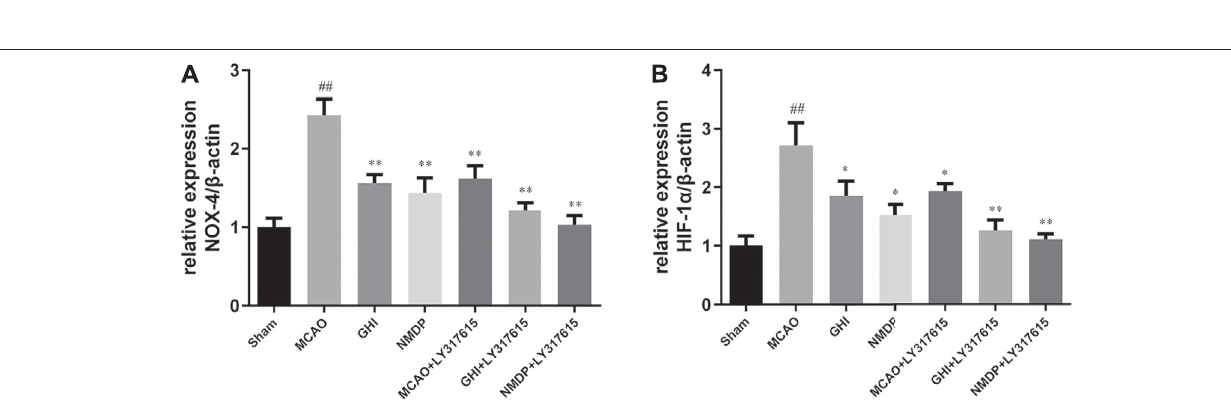
Frontiers in Pharmacology |